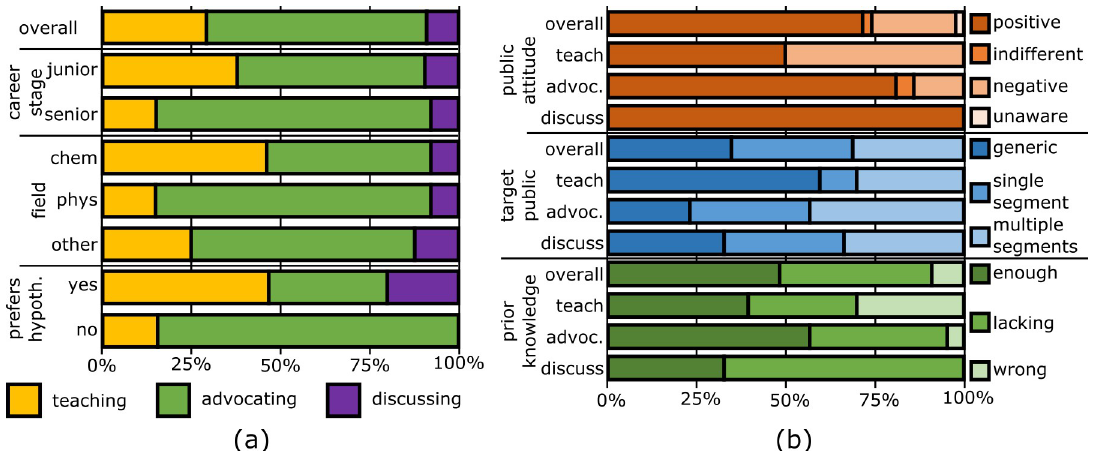
Fig 3. Communication profiles prevalence and view of the public (n = 33). (a) Prevalence of the teaching (yellow), advocating (green), and discussing (purple) profiles when segmenting the sample by career stage, field, and hypothesis preference of the researchers; (b) View of public attitude towards OoL (brown series), target public (blue series), and public’s prior knowledge of OoL (green series) seen by all scientists (overall), as well as by the different communication profiles.